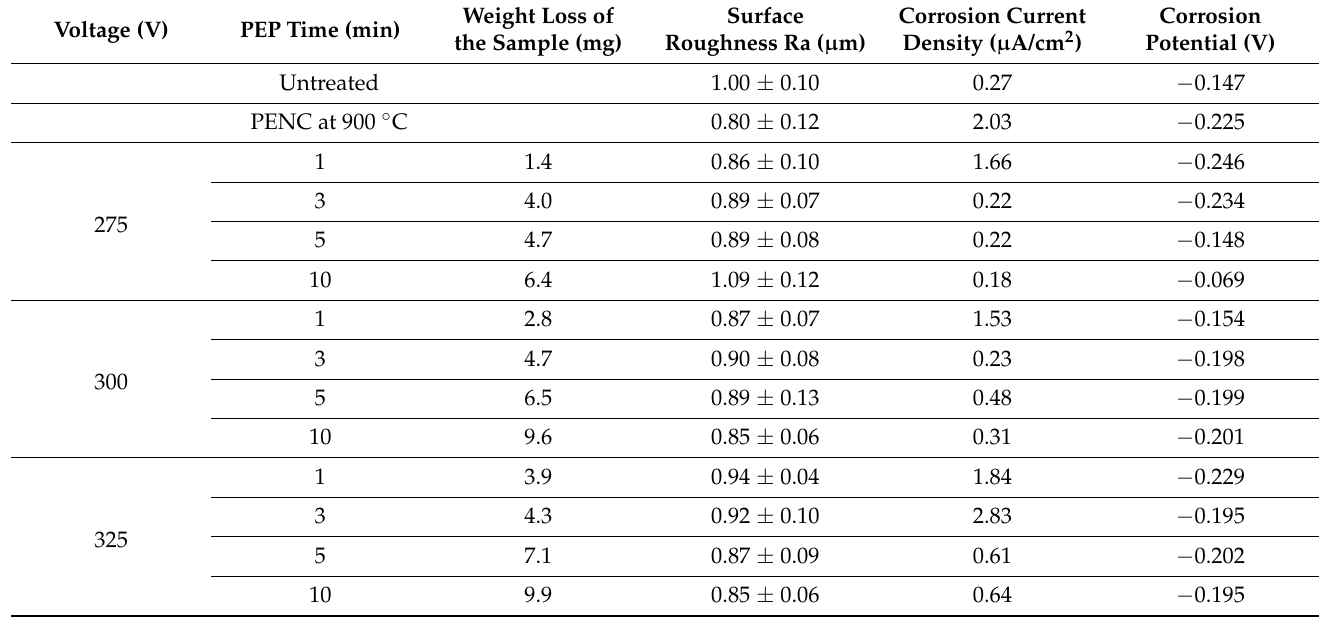
Table 2. Values of weight loss, surface roughness, corrosion current density and corrosion potential of CP-Ti samples after anodic PENC at 900 ◦ C and subsequent PEP in a solution of ammonium sulfate